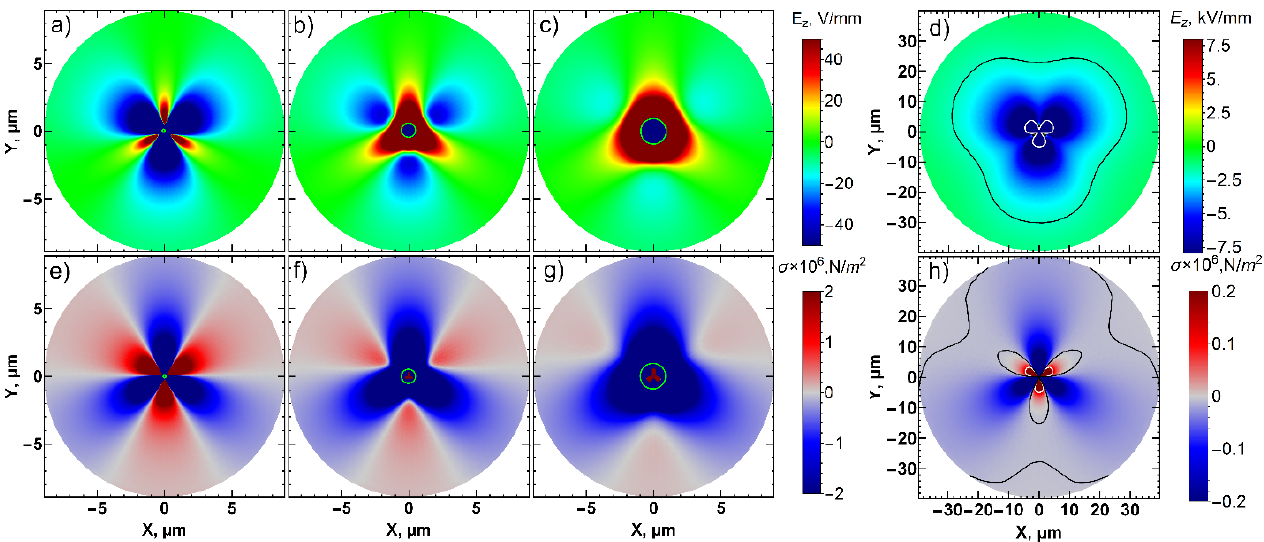
Figure 5. Simulated distributions of ( a – d ) E z, and ( e – h ) mechanical stress, s, at the 20 nm depth with different radius of the c -domain in the center (green circle): ( a , d ) 50 nm, ( b , e ) 500 nm, ( c , f ) 1000 nm. ( d , e ) 50 nm, larger scale. The green line corresponds to the c -domain wall. The black line corresponds to threshold field for the a ↑ -domain ~ − 2 V/mm (1.4 × 10 5 N/m 2 stress), while the white line corresponds to the threshold field for a ↓ -domains ~ − 20 V/mm (7 × 10 3 N/m 2 stress).